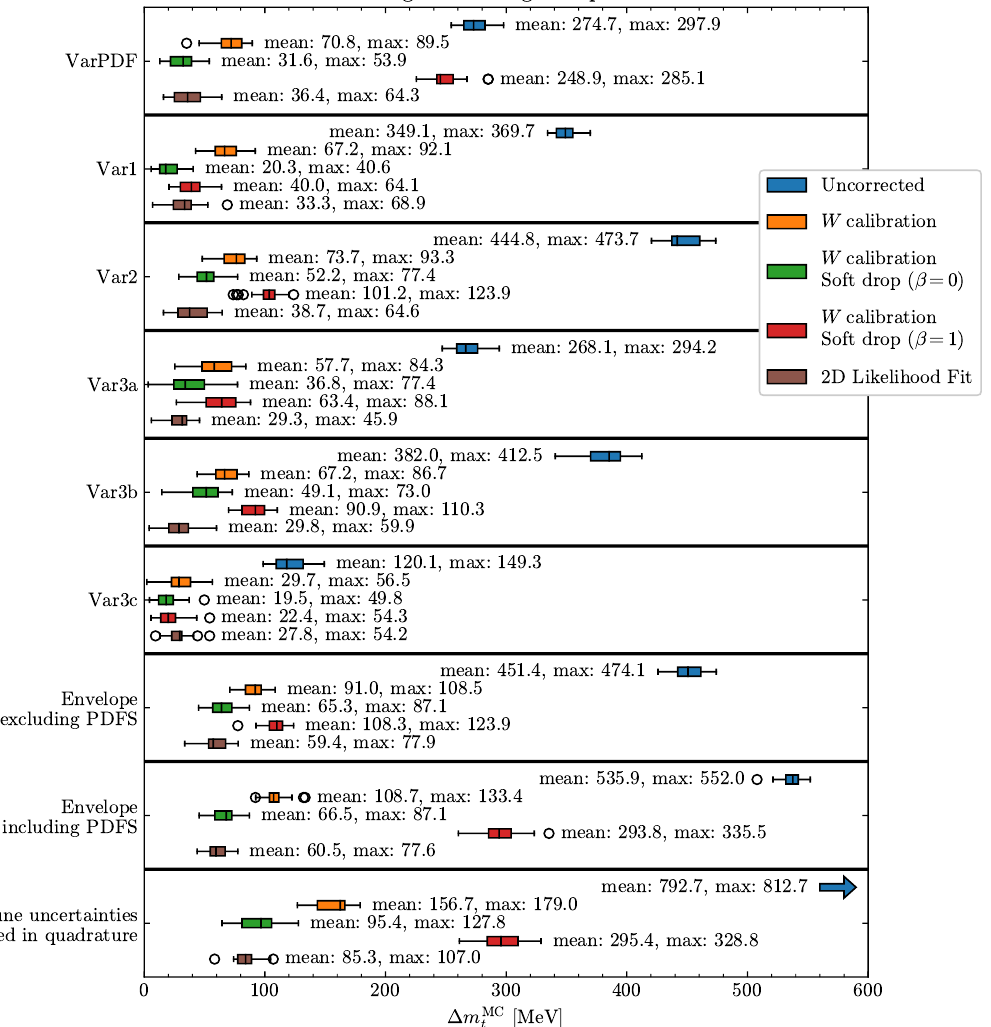
Figure 4. Box-and-whisker plot for the uncertainties on the top mass histogram fit and profile likelihood fit within each group of variations in the A14 set of tunes, as in figure 2. The open circles denote outliers which are further away from the box than 1.5 box lengths. The uncertainties are calculated with and without W calibration and soft drop grooming methods. The bottom three rows show several ways of combining the error for the different